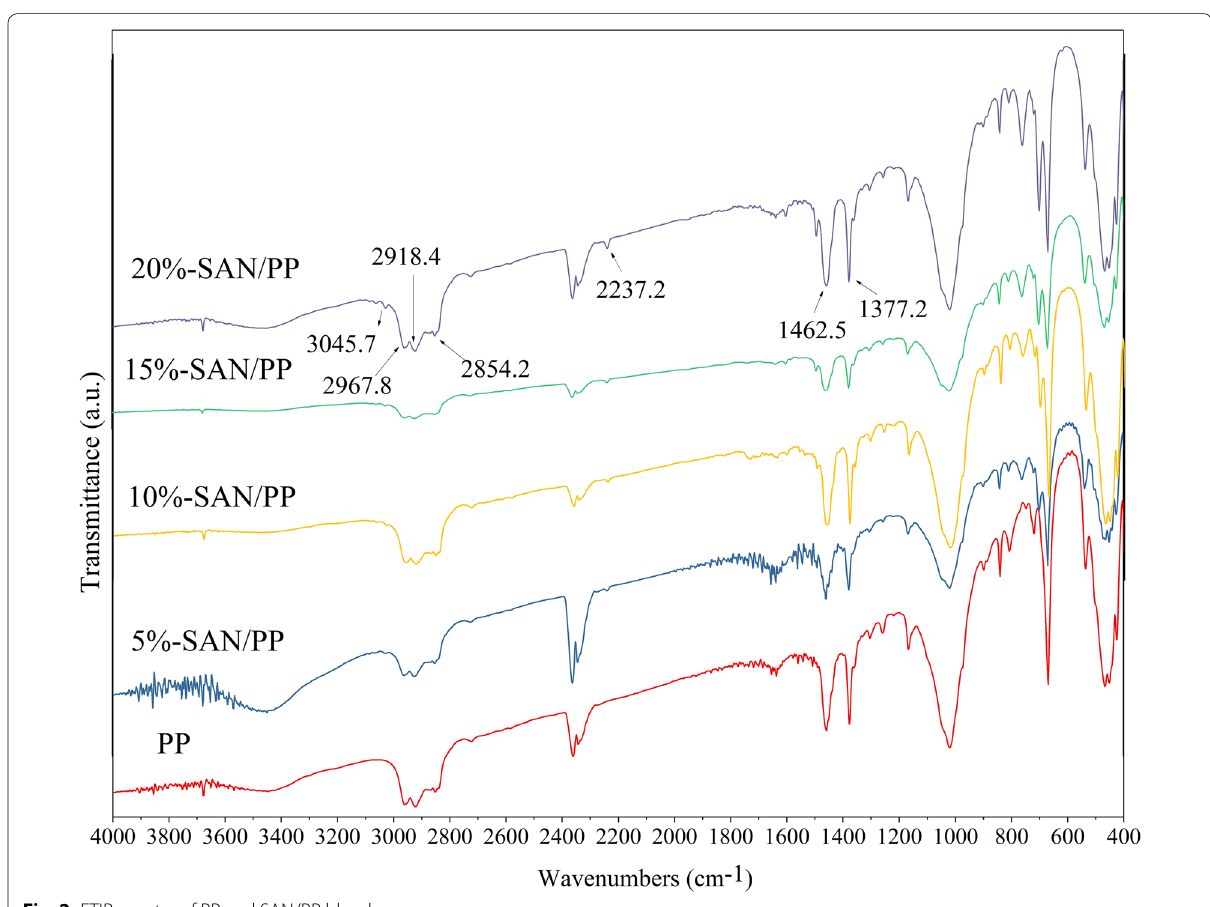
Fig. 2 FTIR spectra of PP and SAN/PP